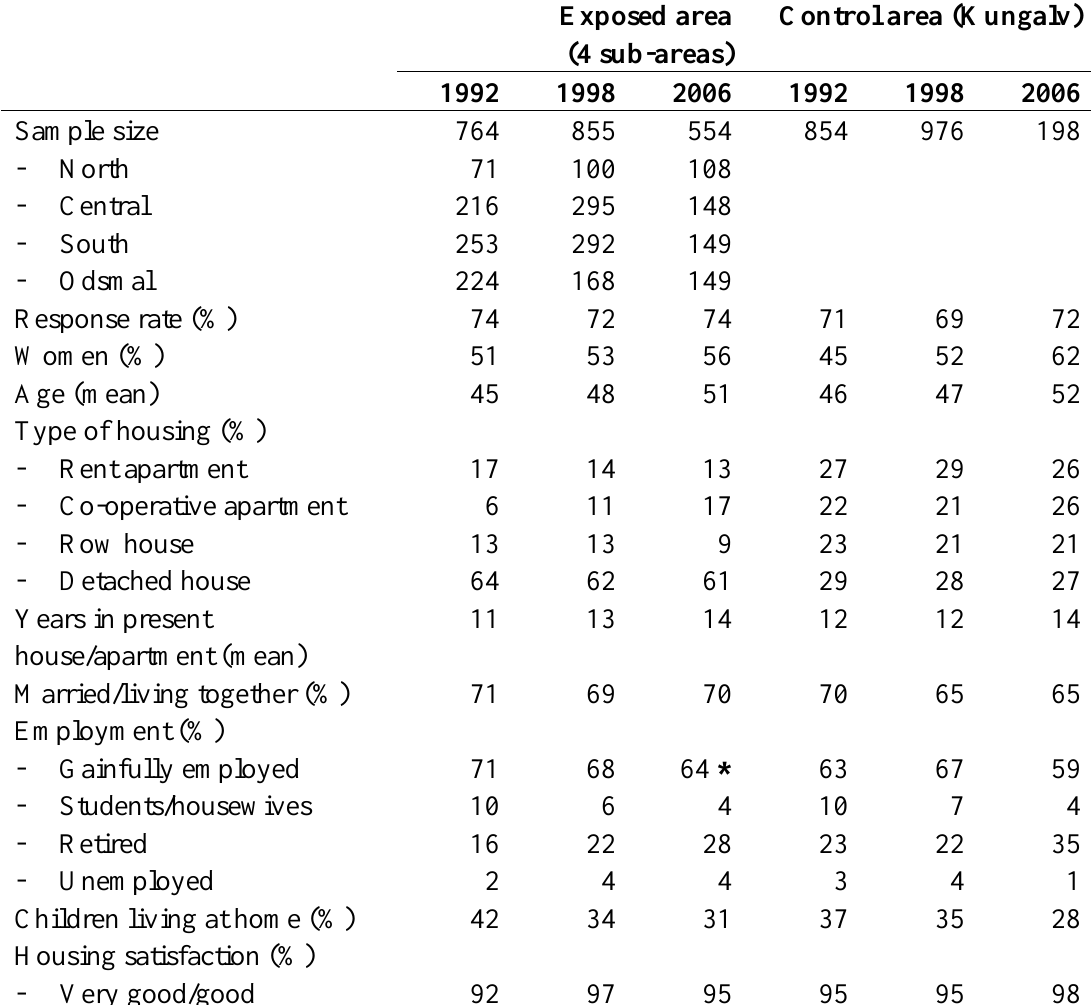
Table 1. Background data on the respondents in the exposed area and the control area, on three